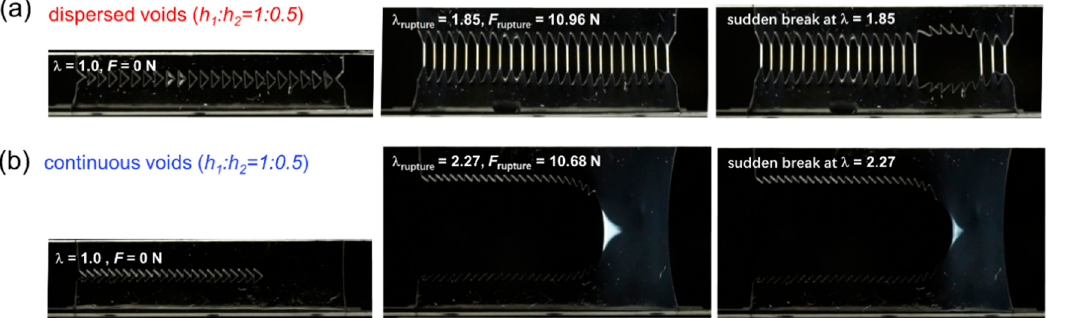
Figure 5. Birefringence observation during fracture of D-cut and C-cut gels at spacing ratio h 1 : h 2 of 1:0.5. ( a , b ) The representative snapshots of crack evolution in DN hydrogel samples under different structural models containing dispersed cuts (( a ) D-cut gel) and continuous cuts (( b ) C-cut gel) at spacing ratio h 1 : h 2 of 1:0.5.